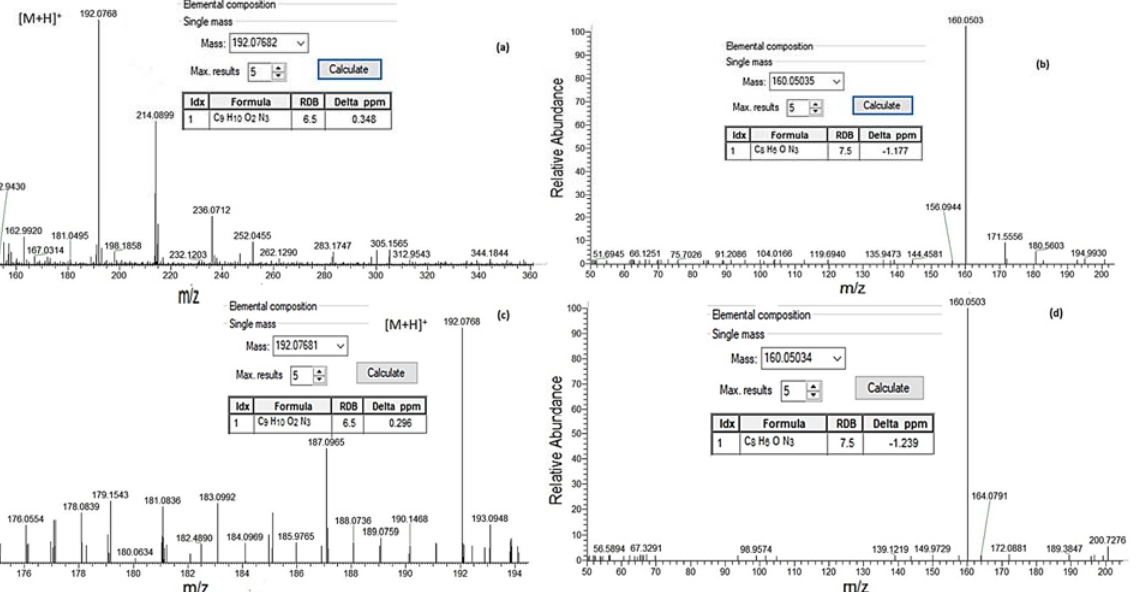
Figure 5. ( a ) Full scan accurate mass parent ion spectrum and ( b ) MS/MS data obtained for car ‐ dazim in standard solution at a concentration of 50 µ g kg − 1 . ( c ) Full scan mass parent ion spectrum bendazim in standard solution at a concentration of 50 μ g kg − 1 . ( c ) Full scan mass parent ion spec ‐ and ( d ) MS/MS data obtained for carbendazim in a milk sample from a local trum and ( d ) MS/MS data obtained for carbendazim in a milk sample from a local farm.